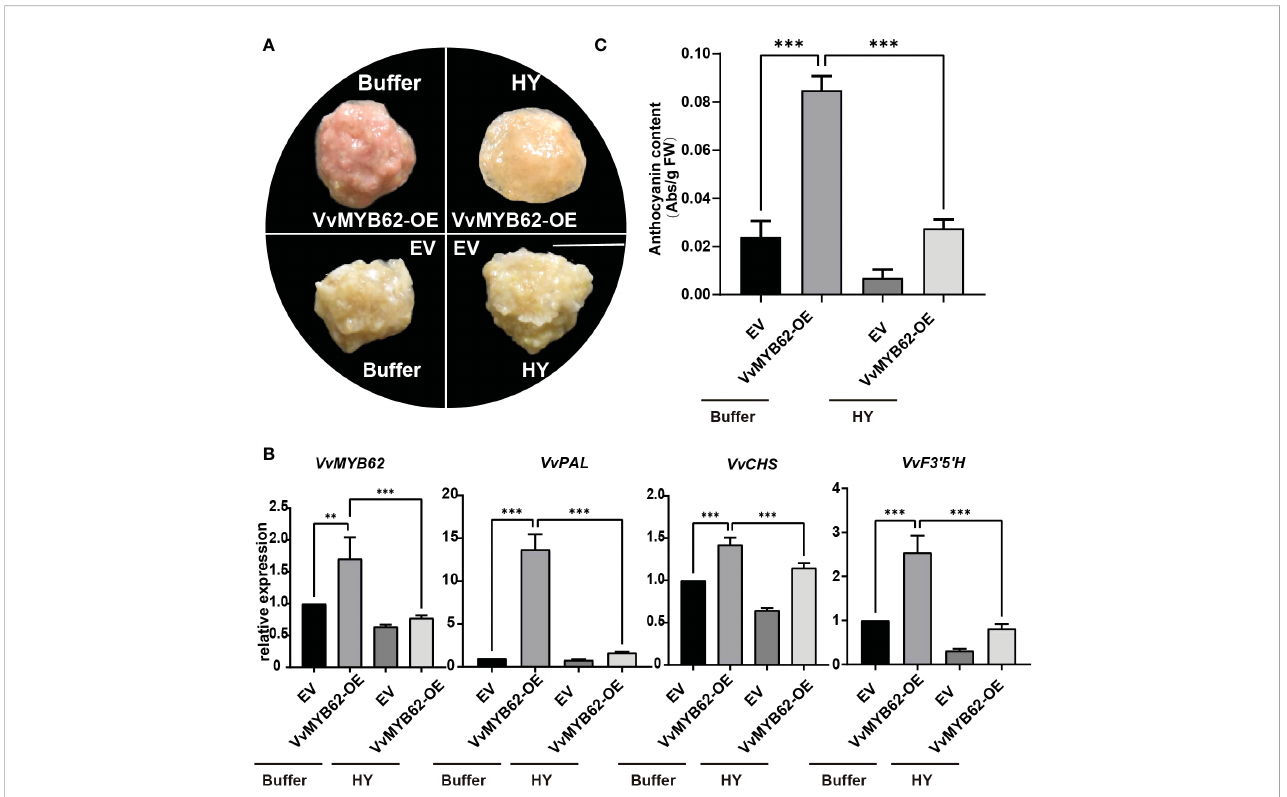
FIGURE 7 Exogenous hyperoside prevented grape calli from expressing VvMYB62 and accumulating anthocyanin. (A) The appearance of the callus after four treatments. A 1 cm scale bar is used. (B) Levels of VvMYB62 , VvPAL, VvCHS , and VvF3 ’ 5 ’ H transcription. An internal control gene was VvActin . (C) The amount of anthocyanin in the CK and OE calli. The mean and standard deviation of three independent biological replicates are used to express values. Signi fi cant statistically: **0.05<P<0.01;